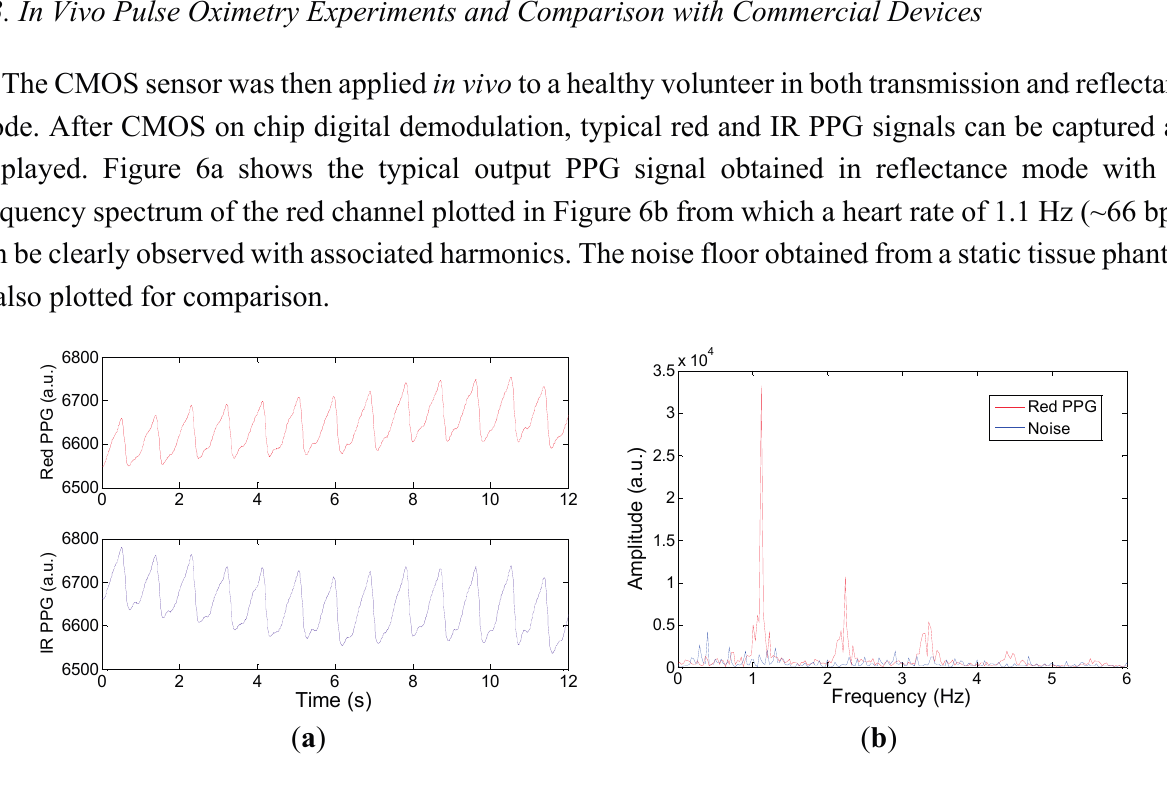
Figure 6. ( a ) Red λ = 660 nm (top) and IR λ = 940 nm (bottom) PPG signals taken in reflectance mode from the finger of a healthy volunteer; ( b ) Frequency spectrum of the Red PPG signal (DC removed) and system noise